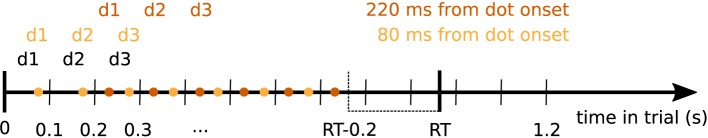
Diagram demonstrating the selection of data points entering the expanded regression analyses. Dot positions (d1, d2, d3, …) changed every 100 ms in the experiment (black). Colored dots indicate times at which signal data points entered the analysis for a given time from dot position change (dot onset, shown exemplarily for 80 and 220 ms from dot onset). We only considered time points up to 200 ms before the response in each trial. Colored d1, d2, d3 above the points indicate the dot positions associated with the corresponding signal data points for the given time from dot onset. For each trial, these pairs of signal data and dot positions entered the expanded regression analyses.